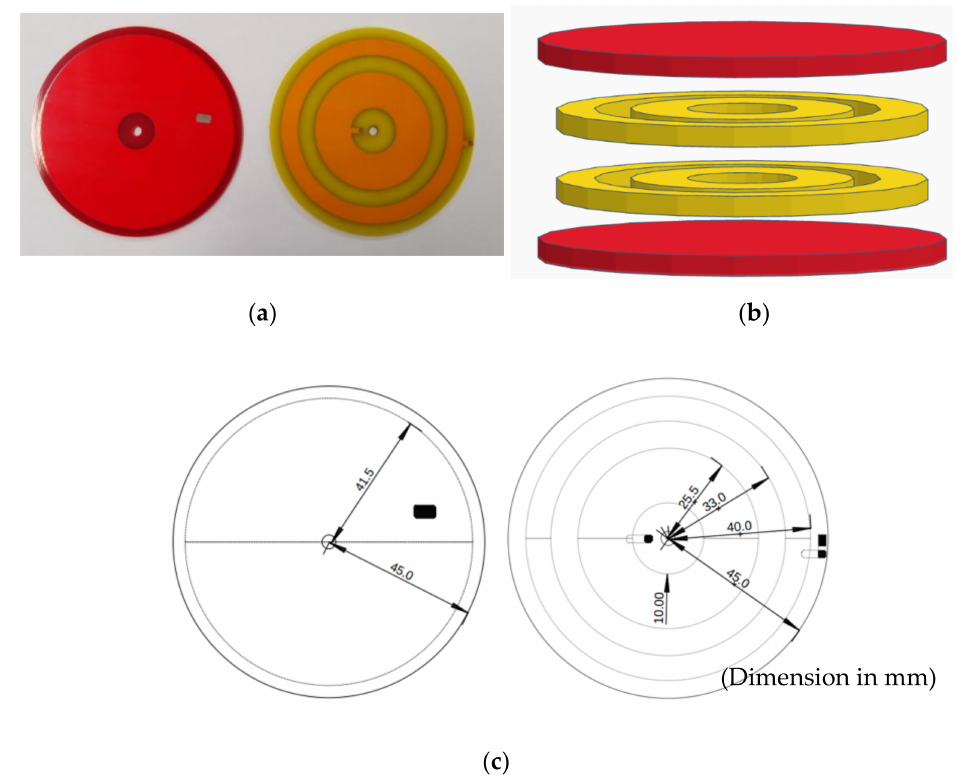
Figure 8. Four-coupler structure with a shielding plate. ( a ) Fabricated coupler hardware. ( b ) Coupler arrangement. ( c ) Two-dimensional (2D) drawing of the coupler